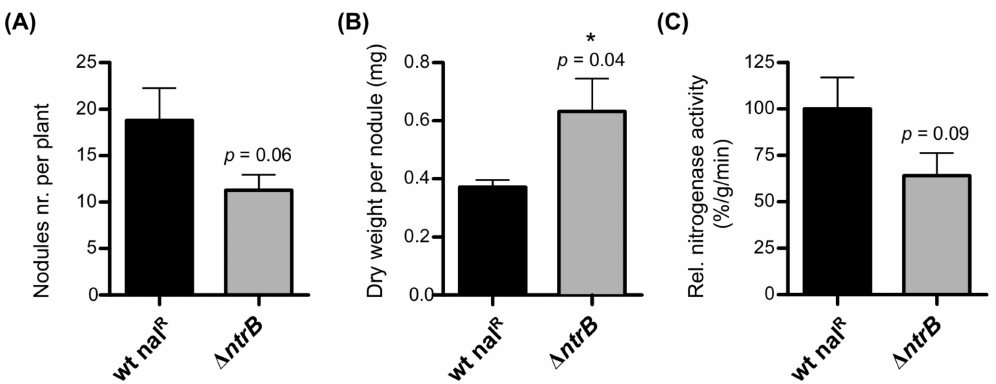
Figure 4. Comparison of the symbiotic properties of P. vulgaris plants inoculated with a ntrB deletion mutant ( ∆ ntrB ) with those of the P. phymatum nalidixic acid-resistant wild-type (wt nal R ) strain. Number of nodules per plant ( A ), dry weight per nodule ( B ), and relative nitrogenase activity ( C ) were determined at 21 days post-infection (dpi). Here, the combined results of two independent experiments are shown. Error bars indicate the standard error of the mean (SEM). The two columns were analyzed by an unpaired student t -test ( p -values are indicated above the SEM, * indicates p -value < 0.05).